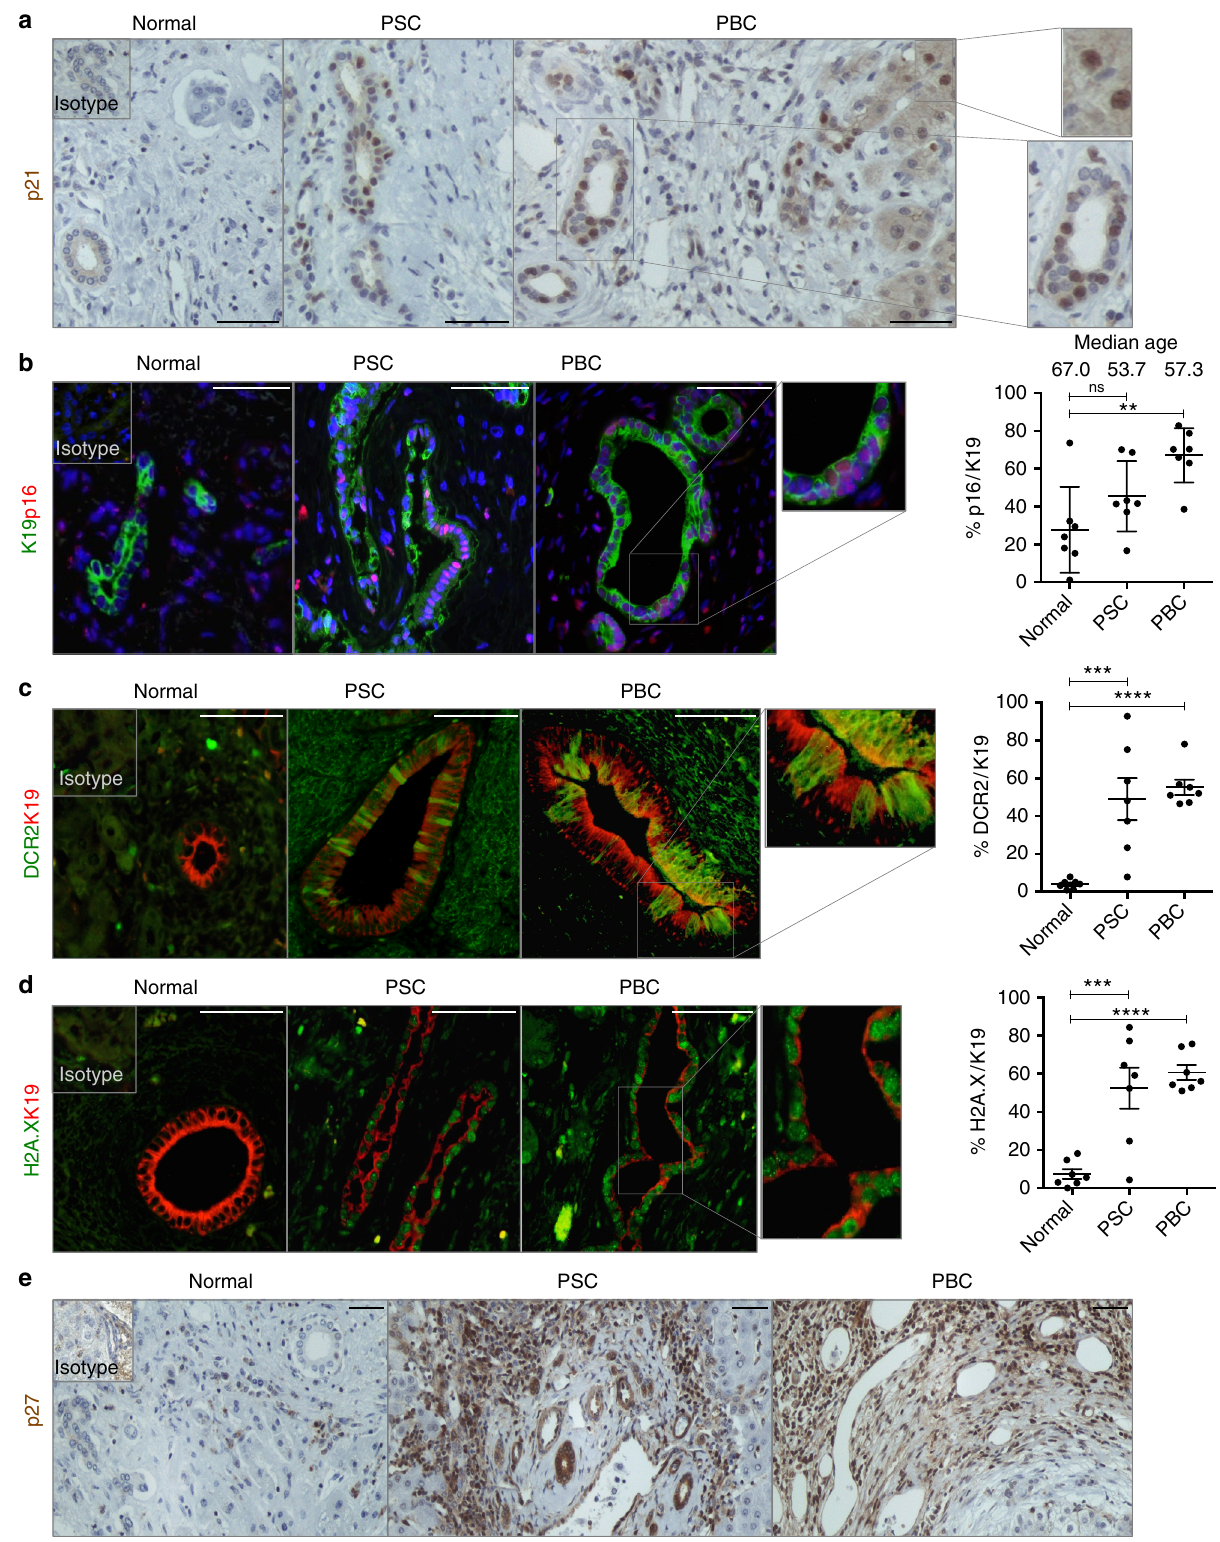
Fig. 1 Cellular senescence is an intrinsic characteristic of PBC/PSC. Explanted human livers diagnosed as Normal, PSC and PBC respectively (series of N = 7 per group). a Immunohistochemical detection of p21 in bile ducts. Far right, digital magni fi cation of p21-positive hepatocytes (top) and cholangiocytes (bottom). b PSC and PBC show p16 expression (red) in cholangiocytes (green). Far right, quanti fi cation of p16 in K19-positive cholangiocytes. Median age of each of the groups is also included in this fi gure. c PSC and PBC show DCR2 expression (green) in cholangiocytes (red). Far right, quanti fi cation. d PSC and PBC show γ H2A. X expression (green) in cholangiocytes (red). Far right, quanti fi cation. e Immunohistochemical detection of p27 increases in PSC and PBC compared to Normal Liver. ** denotes p< 0.01, *** denotes p< 0.001, **** denotes p< 0.0001 (Mean±SEM). ANOVA, Sidak ’ s multiple comparisons test. Scale bars = 50 µ